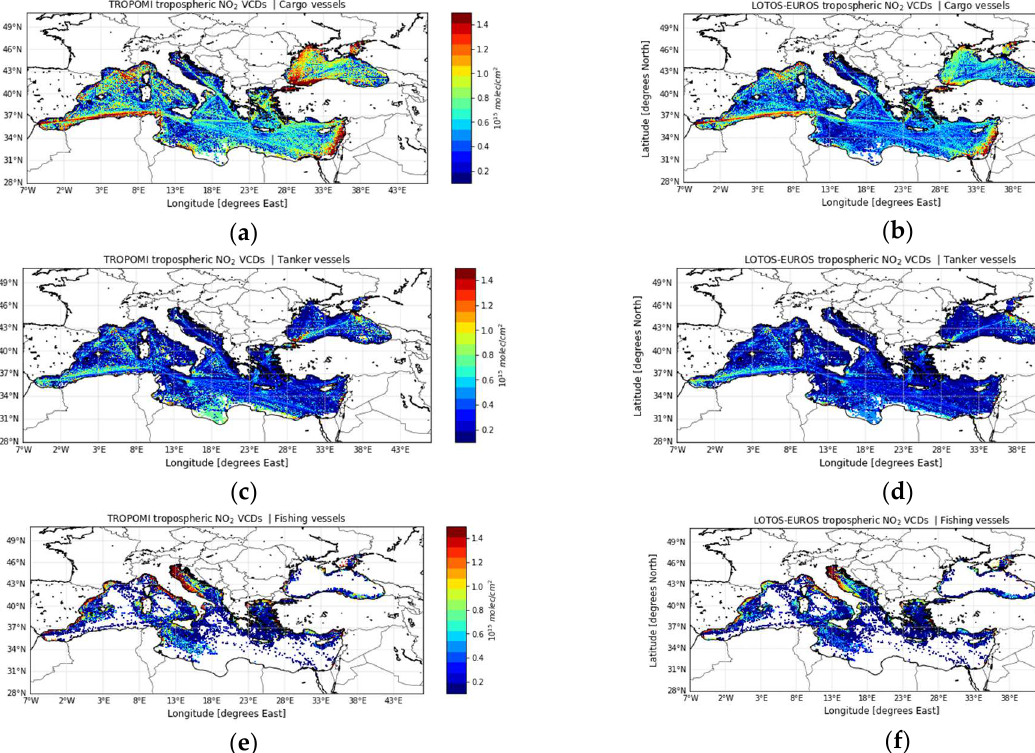
Figure 8. Tropospheric NO 2 vertical column densities (in 10 15 molecules cm − 2 ) classified according to the 2019 vessel density per vessel type: ( a ) TROPOMI cargo; ( b ) LOTOS-EUROS cargo; ( c ) TROPOMI tanker; ( d ) LOTOS-EUROS tanker; ( e ) TROPOMI fishing; ( f ) LOTOS-EUROS fishing.